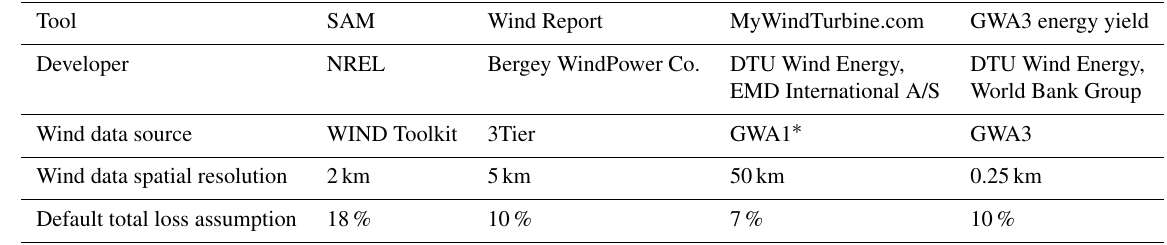
Table 3. Characteristics of the tools that provide annual energy estimates evaluated in this